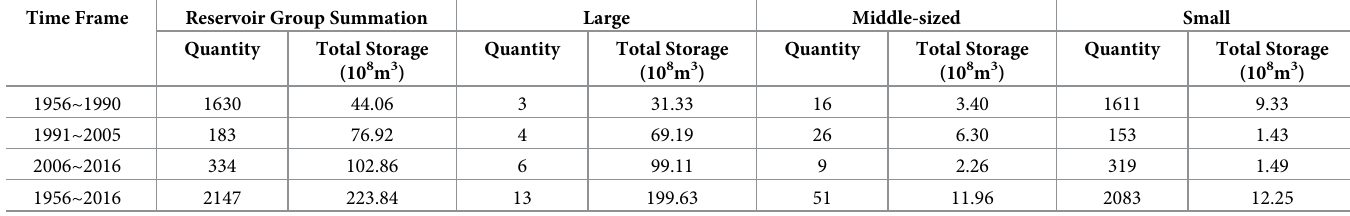
Table 5. Statistics of reservoirs built in Wu Jiang River